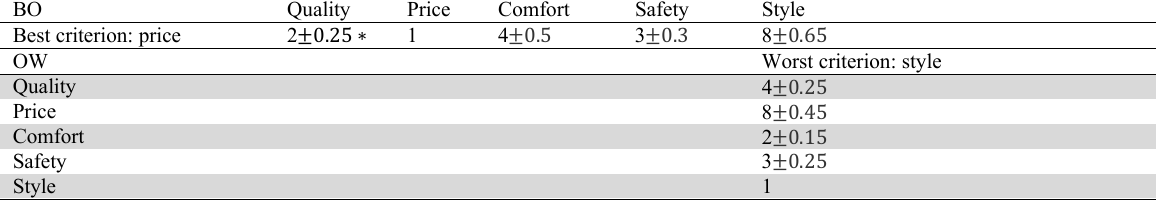
Best-to-others (BO) and others-to-worst (OW) pairwise comparison vectors for Example 1 BO Quality Price Comfort Safety